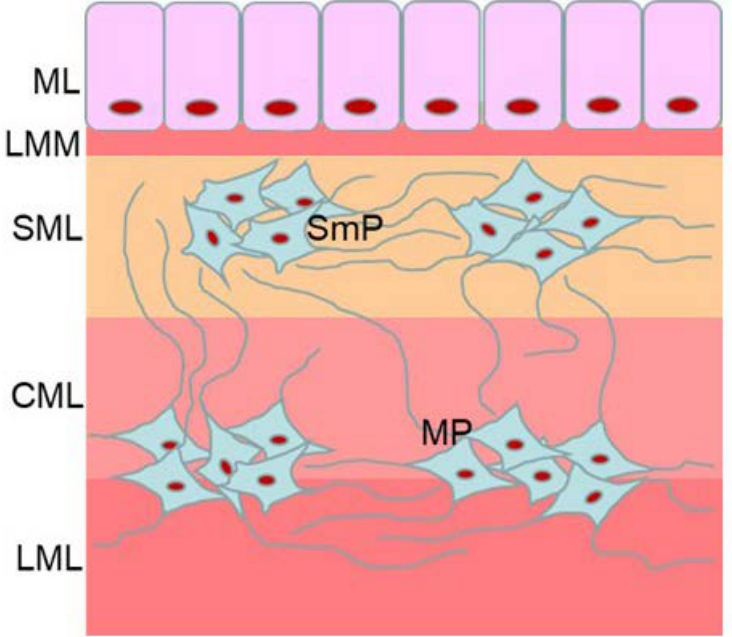
Figure 1. Organization of the enteric nervous system in the mouse large intestine: MP—myenteric plexus, SmP—submucous plexus, LML—longitudinal muscular layer, CML—circular muscular layer, SML—submucosal layer, LMM—lamina muscularis mucosae, ML—mucosal layer.